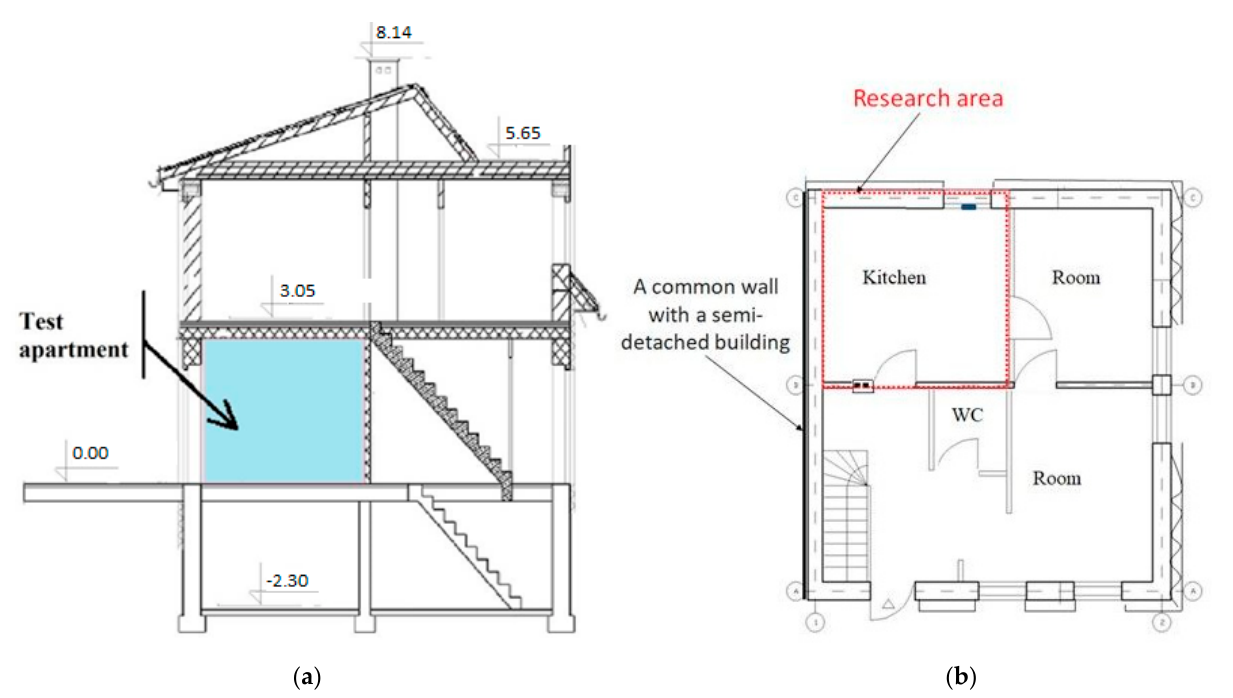
Figure 2. The residential family test house: ( a ) vertical section and ( b ) cross-section of the first floor. Table 1. Overview of construction details for the base case building from